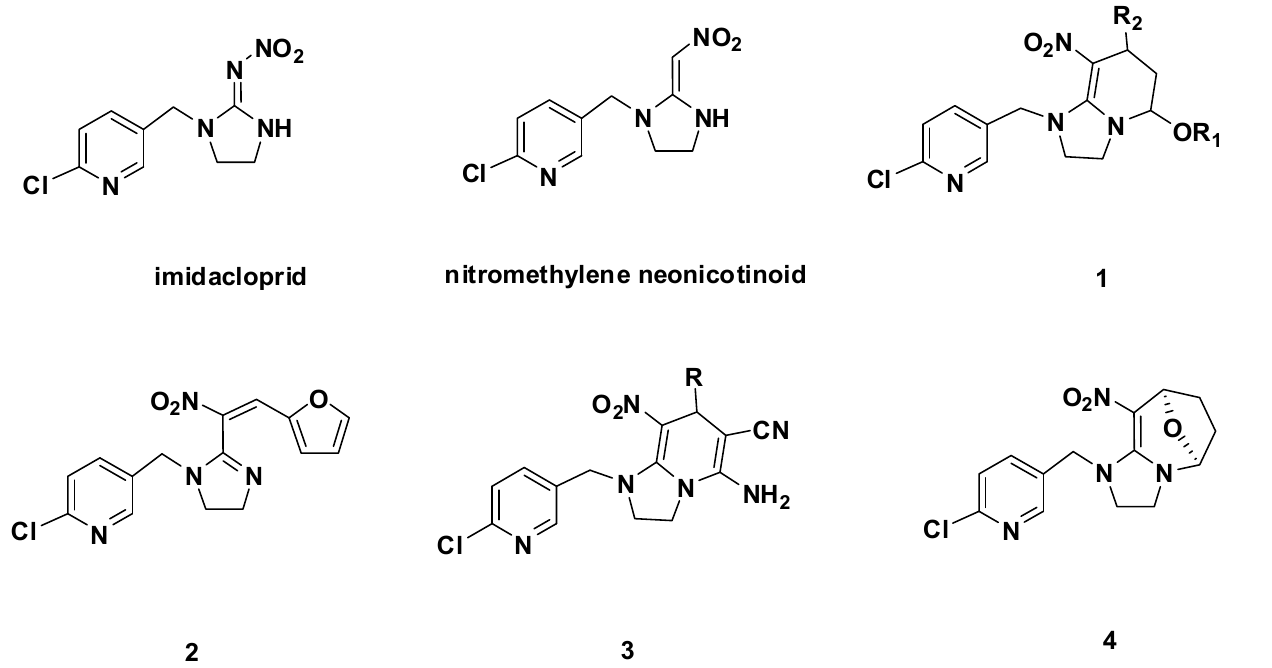
Figure 1. Structures of imidacloprid neonicotinoids and structurally related